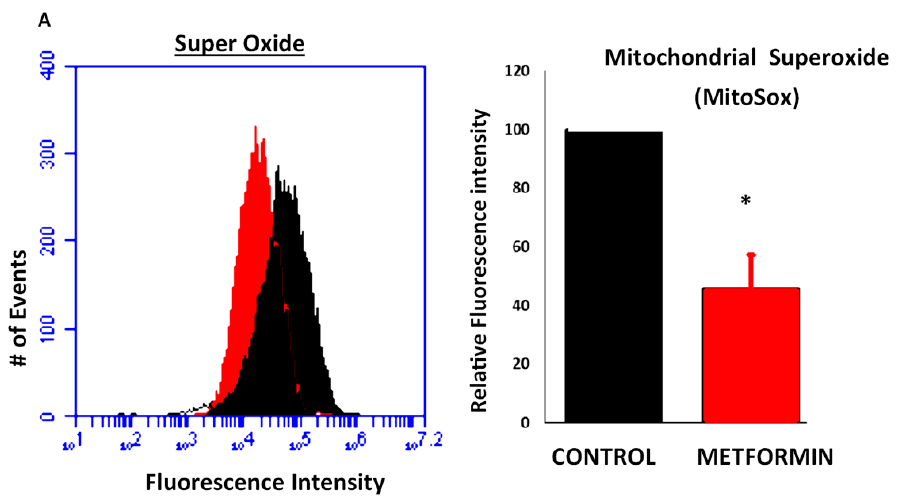
Figure 2. Metformin alleviates endogenous ROS production and subsequent pJNK activation. MDA- MB-231 cells cultured in the presence (red) or absence (black) of metformin (100 µM) for 48 h and subsequently stained with MitoSOX mitochondrial superoxide detection indicator. Fluorescence